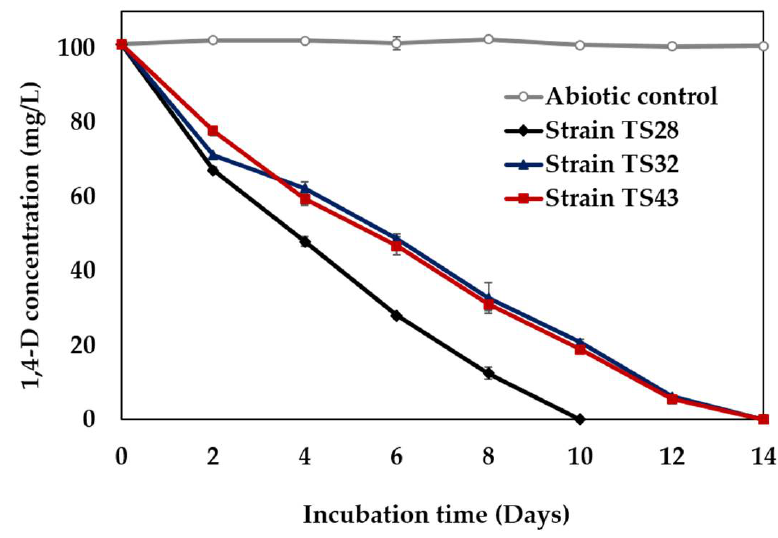
Figure 1. Typical 1,4-D (100 mg/L) degradation profiles of three isolated strains under aerobic conditions. Error bars represent the absolute mean deviations (MD) from the duplicate experiments and may be smaller than the markers.